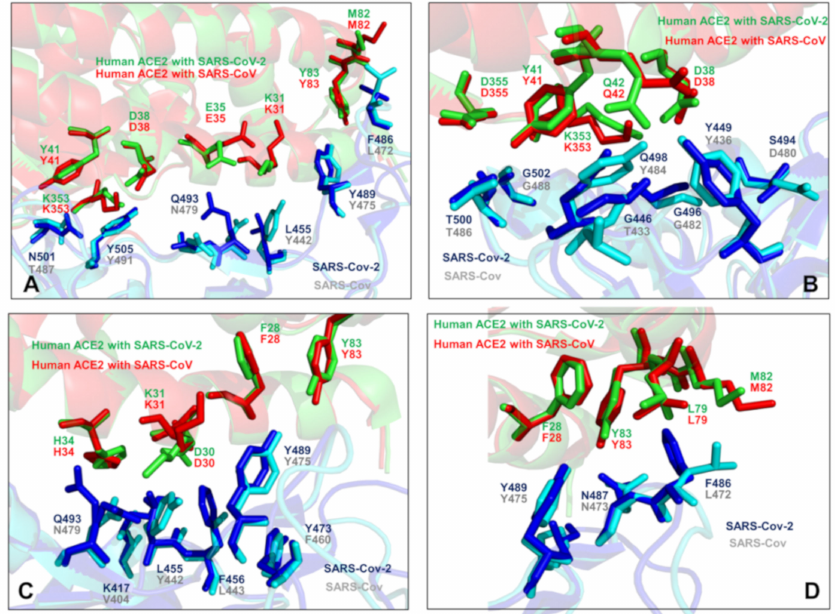
Figure 3. An overview of the binding interface residues in the SARS-CoV-RBD and SARS-CoV-2-RBD complexes with human ACE enzyme. The minimized average equilibrium structures obtained from MD simulations are used to depict the binding interface regions and highlight small conformational changes. ( A ) The N-terminus segment of the interface is shown. The SARS-CoV-RBD residues T487, Y491, N479, Y442, Y475, and L472 from the complex with ACE2 are shown in cyan sticks. The corresponding SARS-CoV-2-RBD residues N501, Y505, Q493, L455, Y489, and F486 are shown in blue sticks. ( B ) Another binding interface region is shown with SARS-CoV-RBD residues T486, G488, T433, G482, Y484, Y436, and D480 (cyan sticks). The corresponding SARS-CoV-2-RBD residues T500, G502, G446, G496, Q498, Y449, and S494 are shown in blue sticks. ( C ) The central segment of the binding interface with SARS-CoV-RBD residues N479, V404, Y442, L443, F460, and Y475 (cyan sticks). The SARS-CoV-2-RBD residues are Q493, K417, L455, F456, Y473, and Y489 (blue sticks). ( D ) The binding interface flexible ridge with SARS-CoV-RBD residues Y475, N473, and L472 (cyan sticks) and SARS-CoV-2-RBD residues Y489, N487, and F486 (in blue sticks). In all panels ACE2 interacting residues are annotated and shown in red sticks for the SARS-CoV-RBD complex and green sticks for the complex with